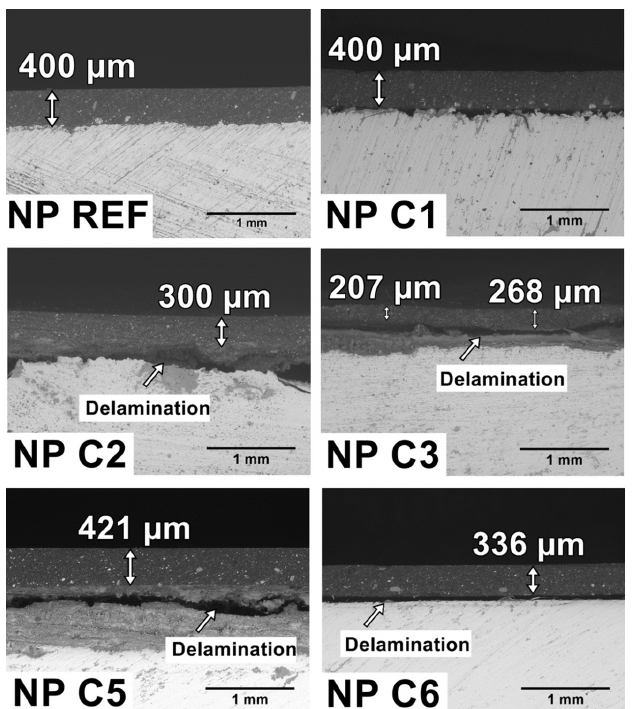
O paint (NP) samples exposed to immersion 2 5